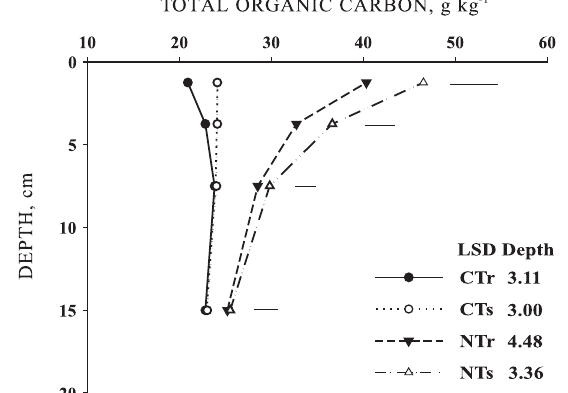
Figure 2. Total organic carbon in conventional tillage (CT) and no-tillage (NT) systems and in rotation (r) and succession (s) crop systems, on a Humic Cambisol, Lages, 2008. Horizontal bars indicate least significant differences between treatments at the same depth, based on the t test (p < 0.05). n = 64